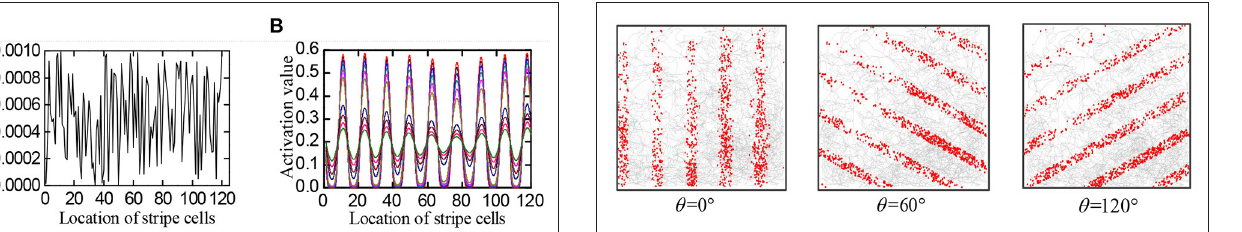
FIGURE 9 | The process of stripe formation. (A) The initial firing of the stripe cells neural plate under the action of noise. (B) Striped firing pattern were formed spontaneously over time, the curve from green to red, respectively, represents the striped firing pattern from 50 to 500 ms .